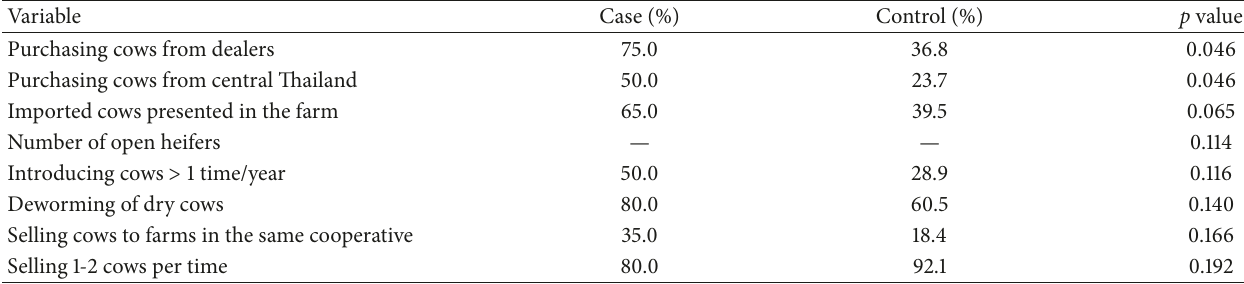
Table 1: Univariate analysis of variables as 𝑝 ≤ 0.2 considered for multivariate analysis and the percentage of the distribution of the risk factors in case- and control-farms.